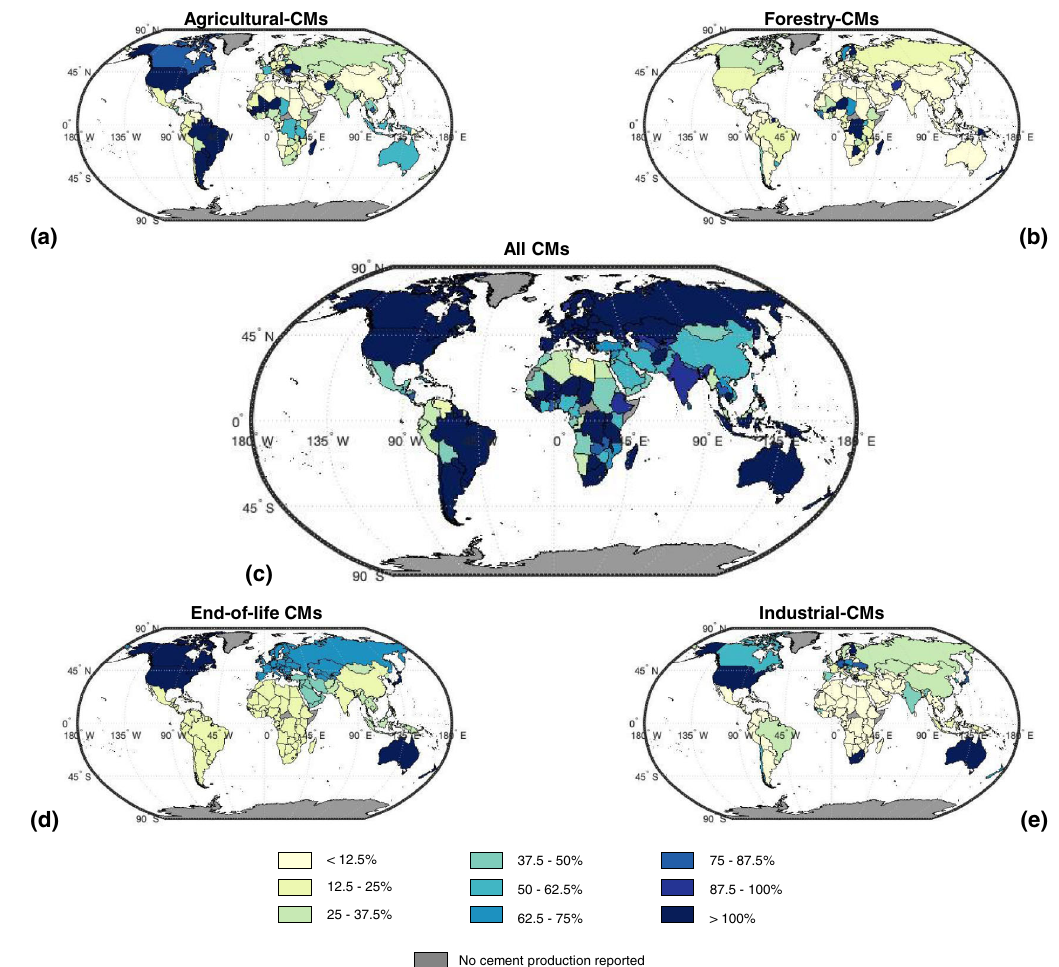
Fig. 3 | Geographic breakdown of potential generation of secondary cementi- tiousmaterials(CMs). Dataareshownonacountry-by-countrybasisforyear2018 using units of mass potential secondary CM generation per mass cement produc- tion (i.e., Gt secondaryCM/Gt cement). a Agriculturalby-productashes. b Forestry